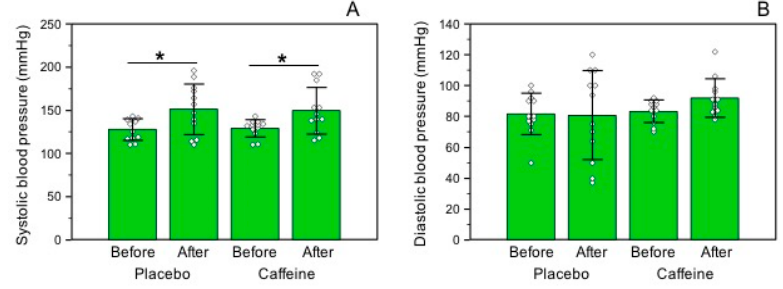
Figure 3. Blood pressure before and after the trials. ( A ) Systolic blood pressure levels ( n = 12) and ( B ) diastolic blood pressure levels ( n = 12). * was considered different from baseline. Data are expressed as means ± standard deviation.